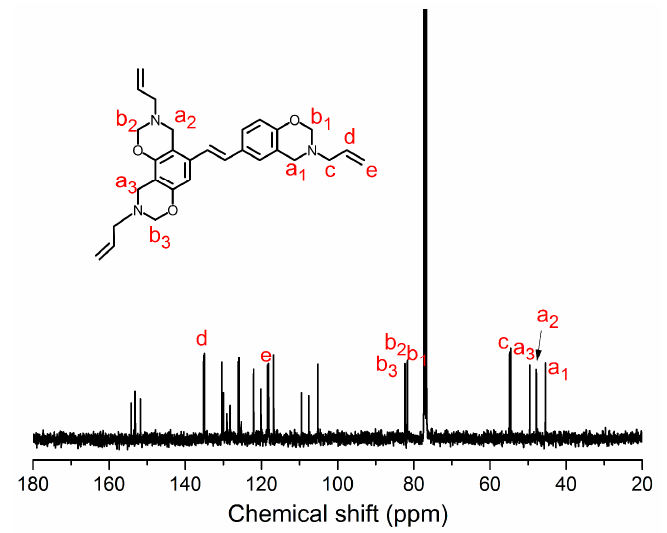
Figure 2. 13 C NMR spectrum of RES-al in CDCl 3 .